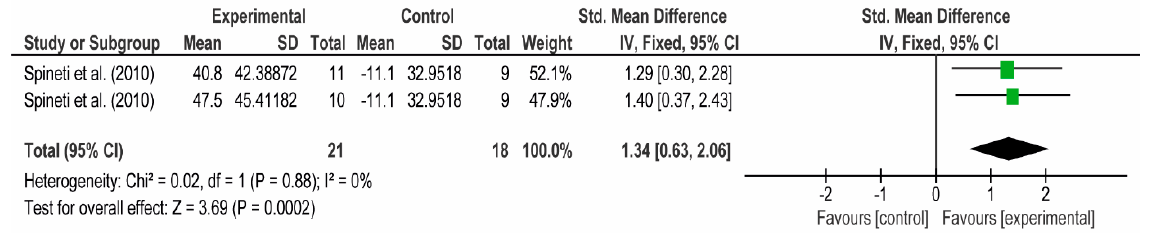
Figure 19. The effect size of 12-weeks of nonlinear periodised resistance training on increasing the Figure 19. The effect size of 12 -weeks of nonlinear periodised resistance training on increasing the Figure 19. The effect size of 12 -weeks of nonlinear periodised resistance training on increasing the Figure 19. The effect size of 12 -weeks of nonlinear periodised resistance training on increasing the biceps brachii MT. The lines for Spineti et al. [90] respectively represent nonlinear periodised large to biceps brachii MT. The lines for Spineti et al. [90] respectively represent nonlinear periodised large biceps brachii MT. The lines for Spineti et al. [90] respectively represent nonlinear periodised large biceps brachii MT. The lines for Spineti et al. [90] respectively represent nonlinear periodised large small muscle training and small to large muscle training groups. to small muscle training and small to large muscle training groups. to small muscle training and small to large muscle training groups. to small muscle training and small to large muscle training groups.